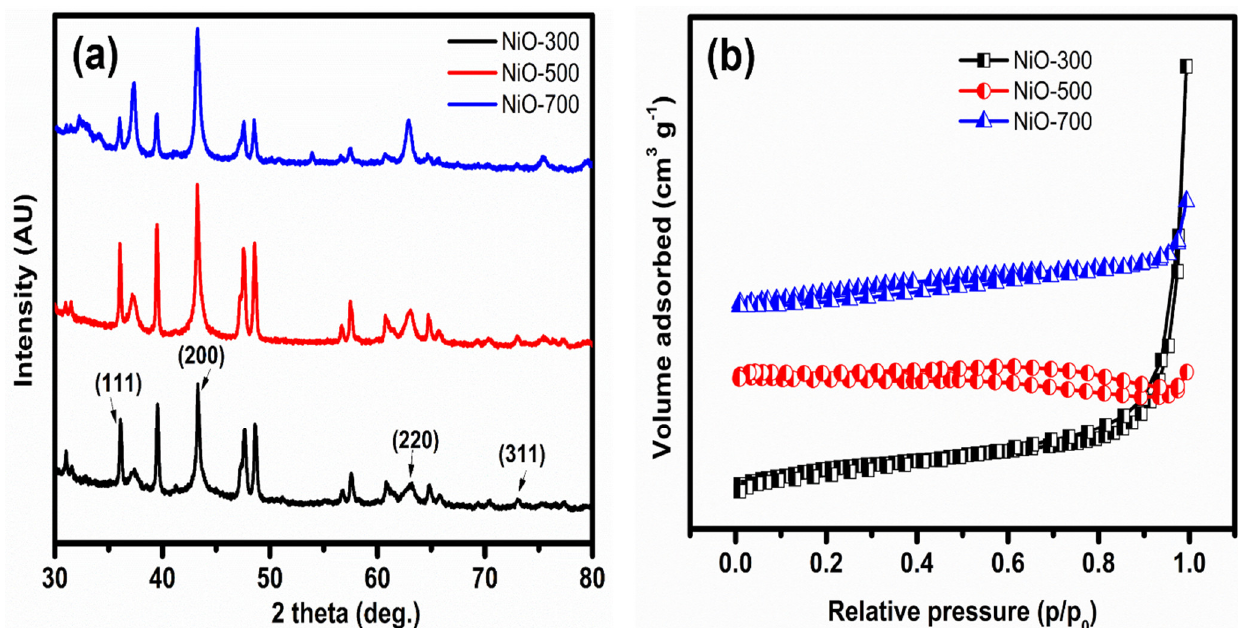
Figure 2. ( a ) XRD and ( b ) N 2 sorption isotherms of NiO materials prepared at three different temperatures.